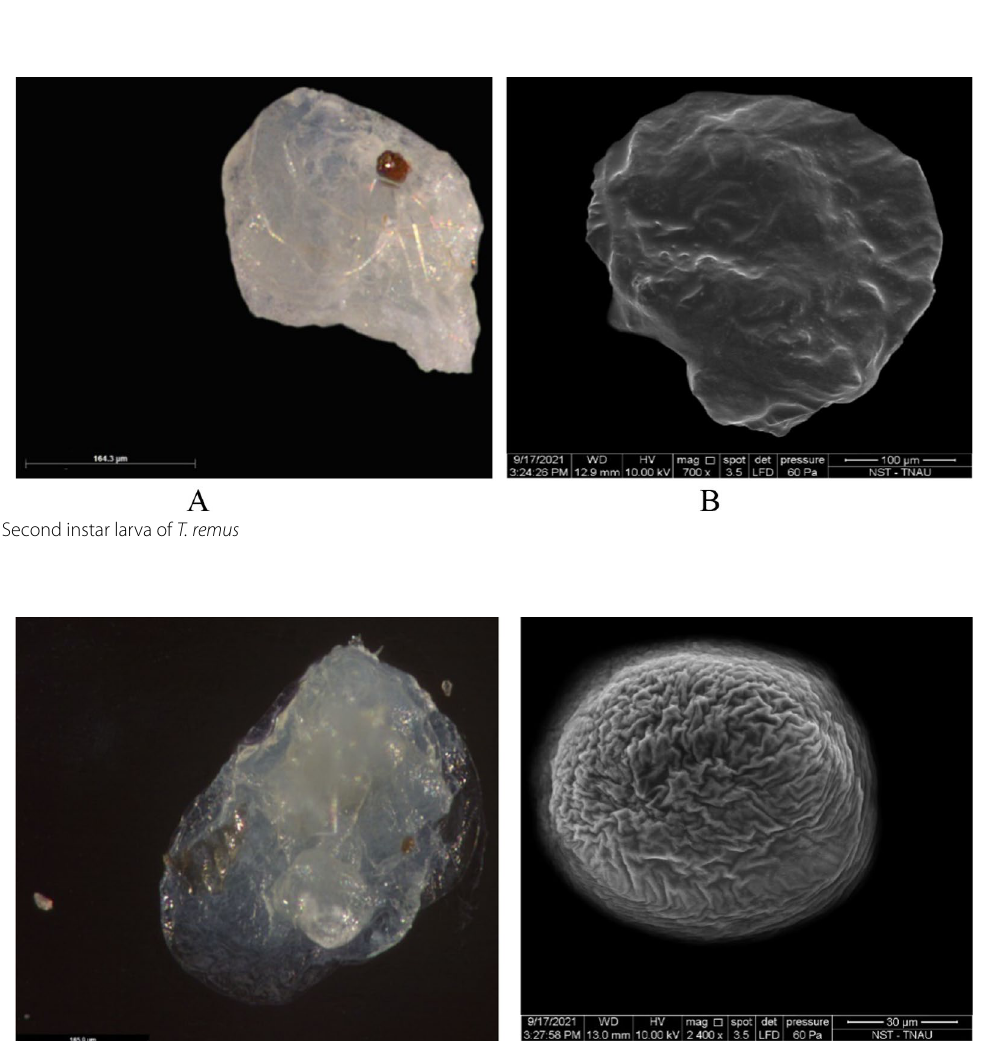
Fig. 4 A, B First instar larva of T. remus